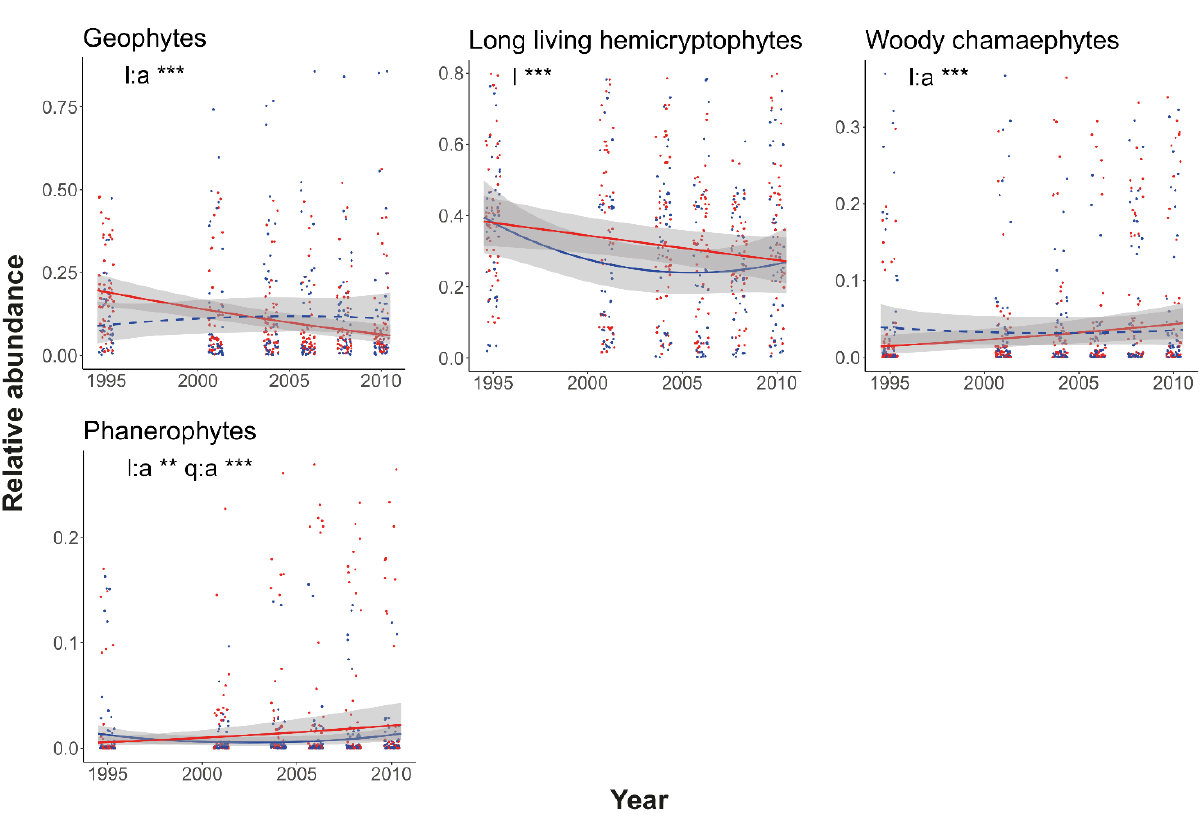
Figure 8. Trends of the relative abundance of growth forms for GC-areas (grazing cessation, red) and GCR- areas (grazing cessation plus rewetting, blue). Regression lines and confidence intervals from individual models are displayed. Solid lines show significant trend components. Dashed lines show the model fit of both trend components, if neither of them is significant. Labels denote significant trend differences or significant overall trends derived from the common model. Dots indicate observed values on single plots. Outliers are not shown. l = linear time component; q = quadratic time component; a = area type; a colon indicates an interaction. Significance levels: *: p ≤ 0.05; **: p ≤ 0.01; ***: p ≤